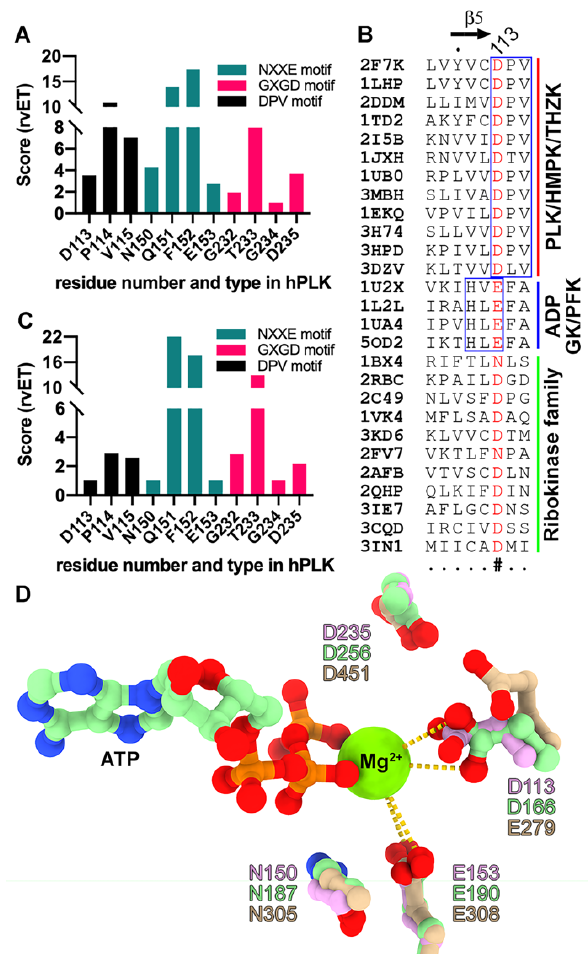
Figure 1. Identification of a third sequence motif that varies among the major groups of the ribokinase superfamily. ( A ) Real-value evolutionary trace (rvET) analysis of a structure-based multiple sequence alignment (MSA) generated for all 27 di ff erent enzymes in Table 1, representing the three major groups of the ribokinase superfamily. ( B ) MSA of the region comprising residues 108–115 of human pyridoxal kinase (hPLK) across all 27 enzymes, grouped according to the three major groups of the ribokinase superfamily. Residues with sequence conservation > 70% across all enzymes are shown in red characters, whereas the HXE motif from ADP-dependent GK and PFK and the DPV motif of PLK, HMPK and THZK are shown in blue boxes. ( C ) rvET analysis of a structure-based MSA generated for 93 PLK, HMPK and THZK sequences shown in Table 2. ( D ) Stick representation of all conserved residues from the NXXE, GXGD and DPV motifs in hPLK (PDB 2F7K, pink), E. coli phosphofructokinase-2 (PDB 3CQD, green) and P. horikoshii GK (PDB 1L2L, brown). The catalytic MgATP from E. coli phosphofructokinase-2 is shown for reference.